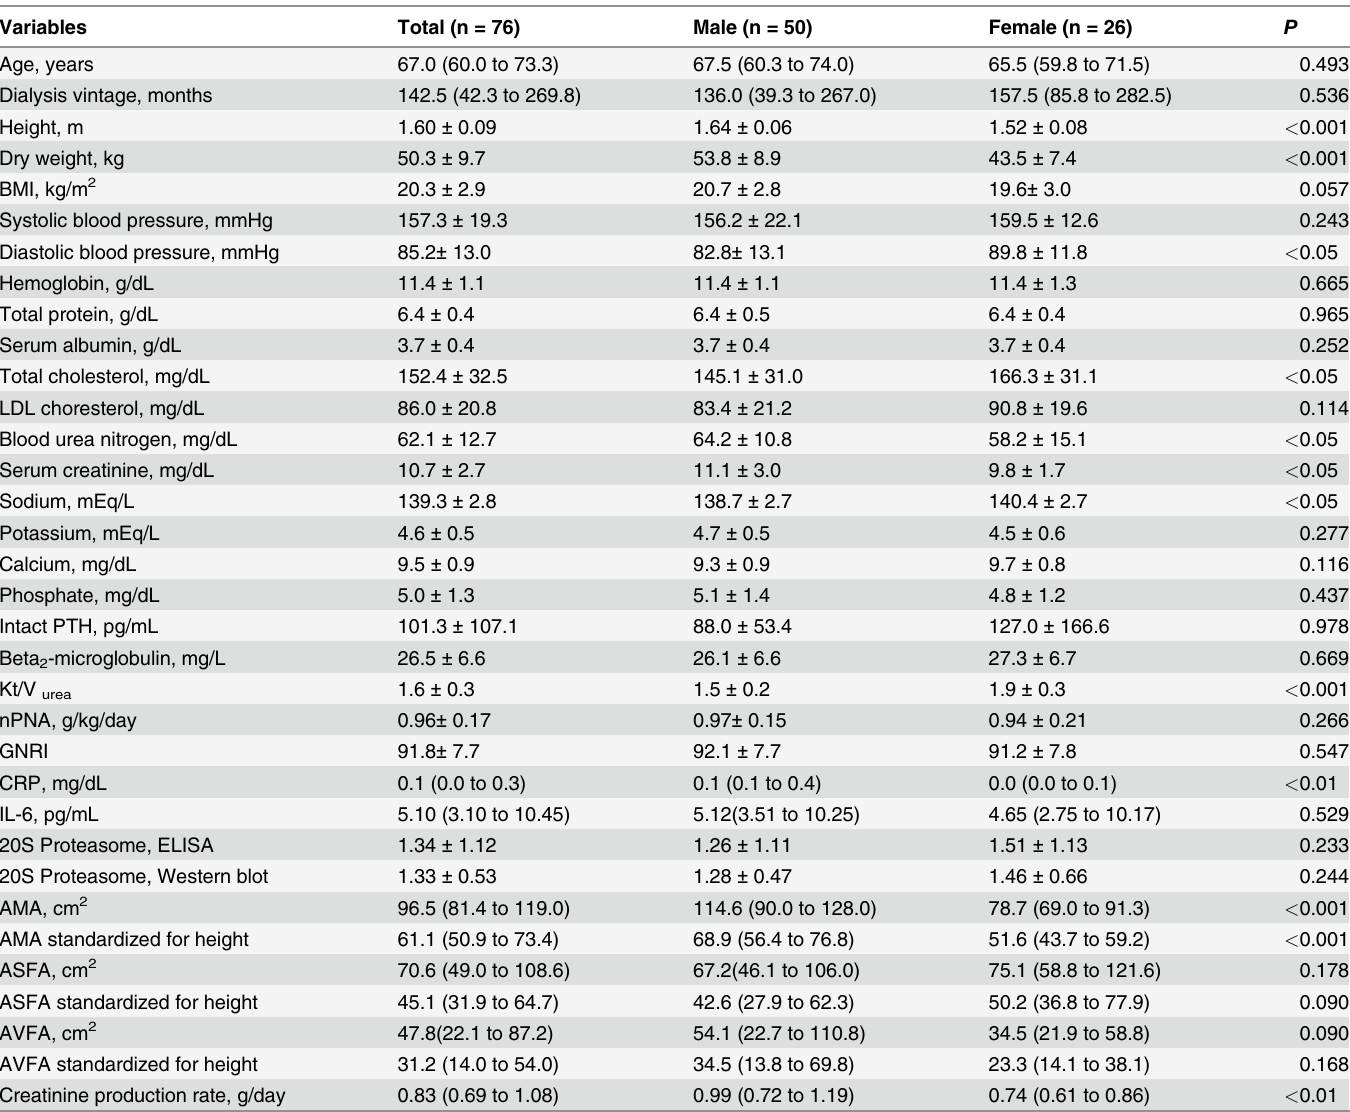
Table 1. Patient Characteristics.